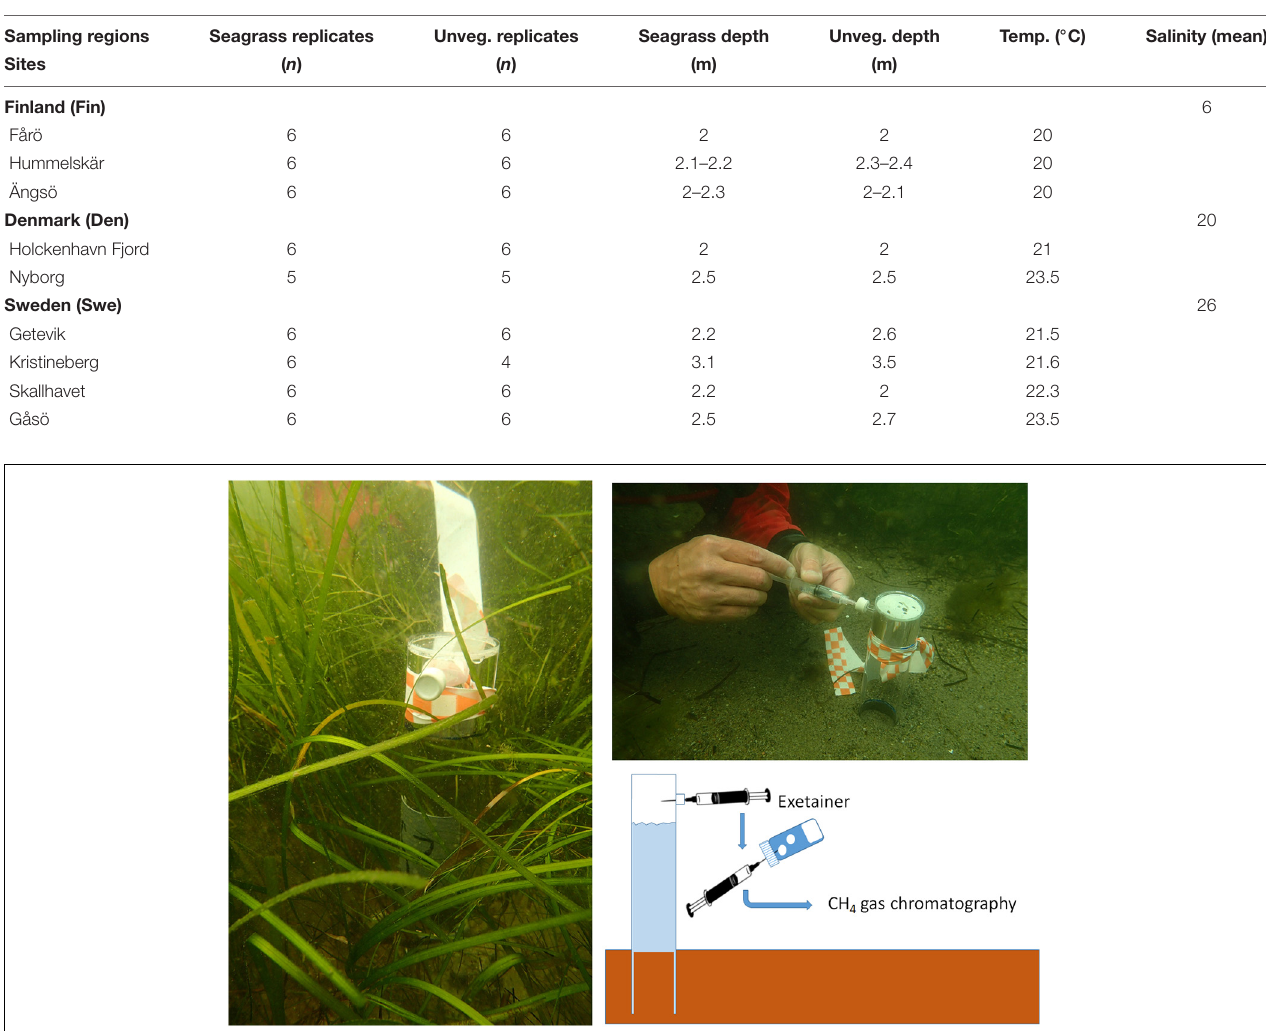
TABLE 1 | Sampling design showing number of replicates, water depth and water temperature in seagrass meadows and adjacent unvegetated habitats at the different sampling sites, and mean salinity for each of the three sampling regions. Sampling regions Seagrass replicates Unveg. replicates